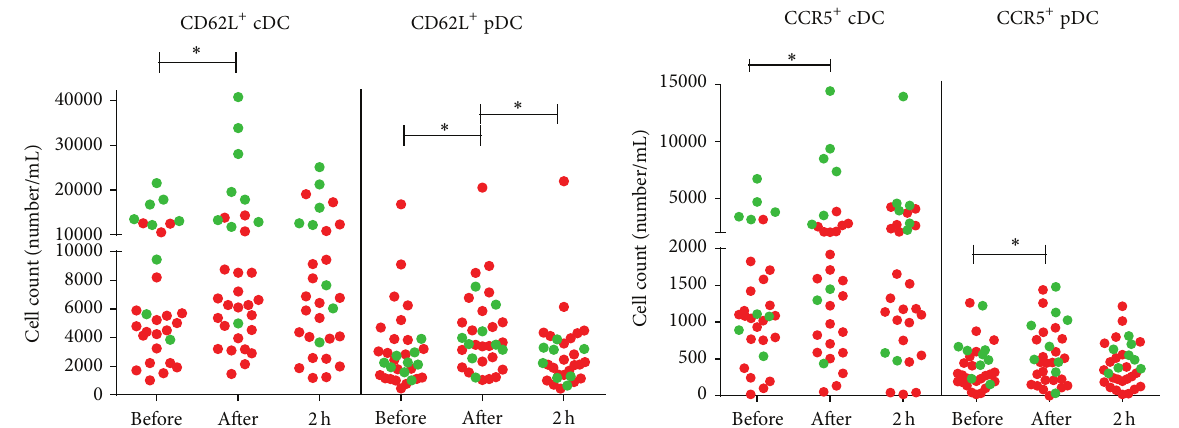
Figure 2: Increased numbers of cDC and pDC expressing the migratory molecules, CD62L and CCR5, upon one exercise bout. The migratory profile of DC was assessed by enumerating cDC and pDC expressing CD62L and CCR5 in healthy controls (green dots) and MS patients (red dots). Results are shown as mean absolute number ± SEM. Significance ( ∗ 𝑃 < 0.05 ) in the complete population of both patients and controls is annotated by black lines. Abbreviations used are as follows: MS: multiple sclerosis; cDC: conventional dendritic cells; pDC: plasmacytoid dendritic cells; CD62L: CD62 ligand; CCR: C-C chemokine receptor; before: measurement before the exercise test; after: measurement immediately after the test; 2h: measurement 2 hours after the test; and SEM: standard error of the